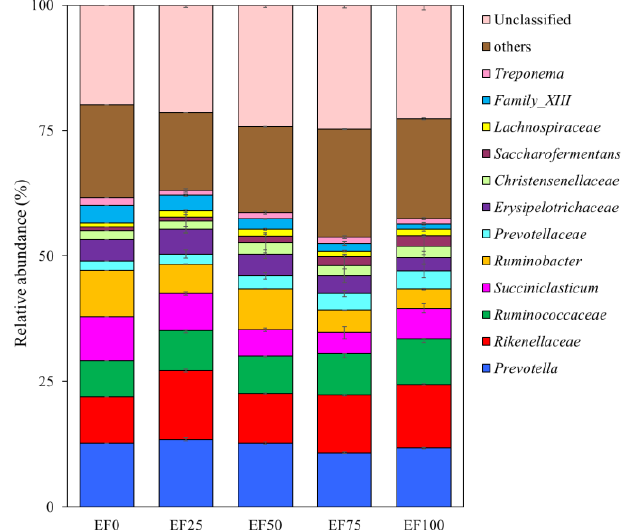
Figure 3. Genus levels composition of rumen microbiota. Different addition levels of endophyte-free Achnatherum inebrians (EF) changed the composition of ruminal microbiota at the genus levels and showed as relative abundance. Only genera with a relative abundance greater than 0.5% are depicted. EF0, EF25, FE50, EF75, and EF100 are defined as EF replacement ratios of 0%, 25%, 50%, 75%, and 100% of the fermentation substrate, respectively.